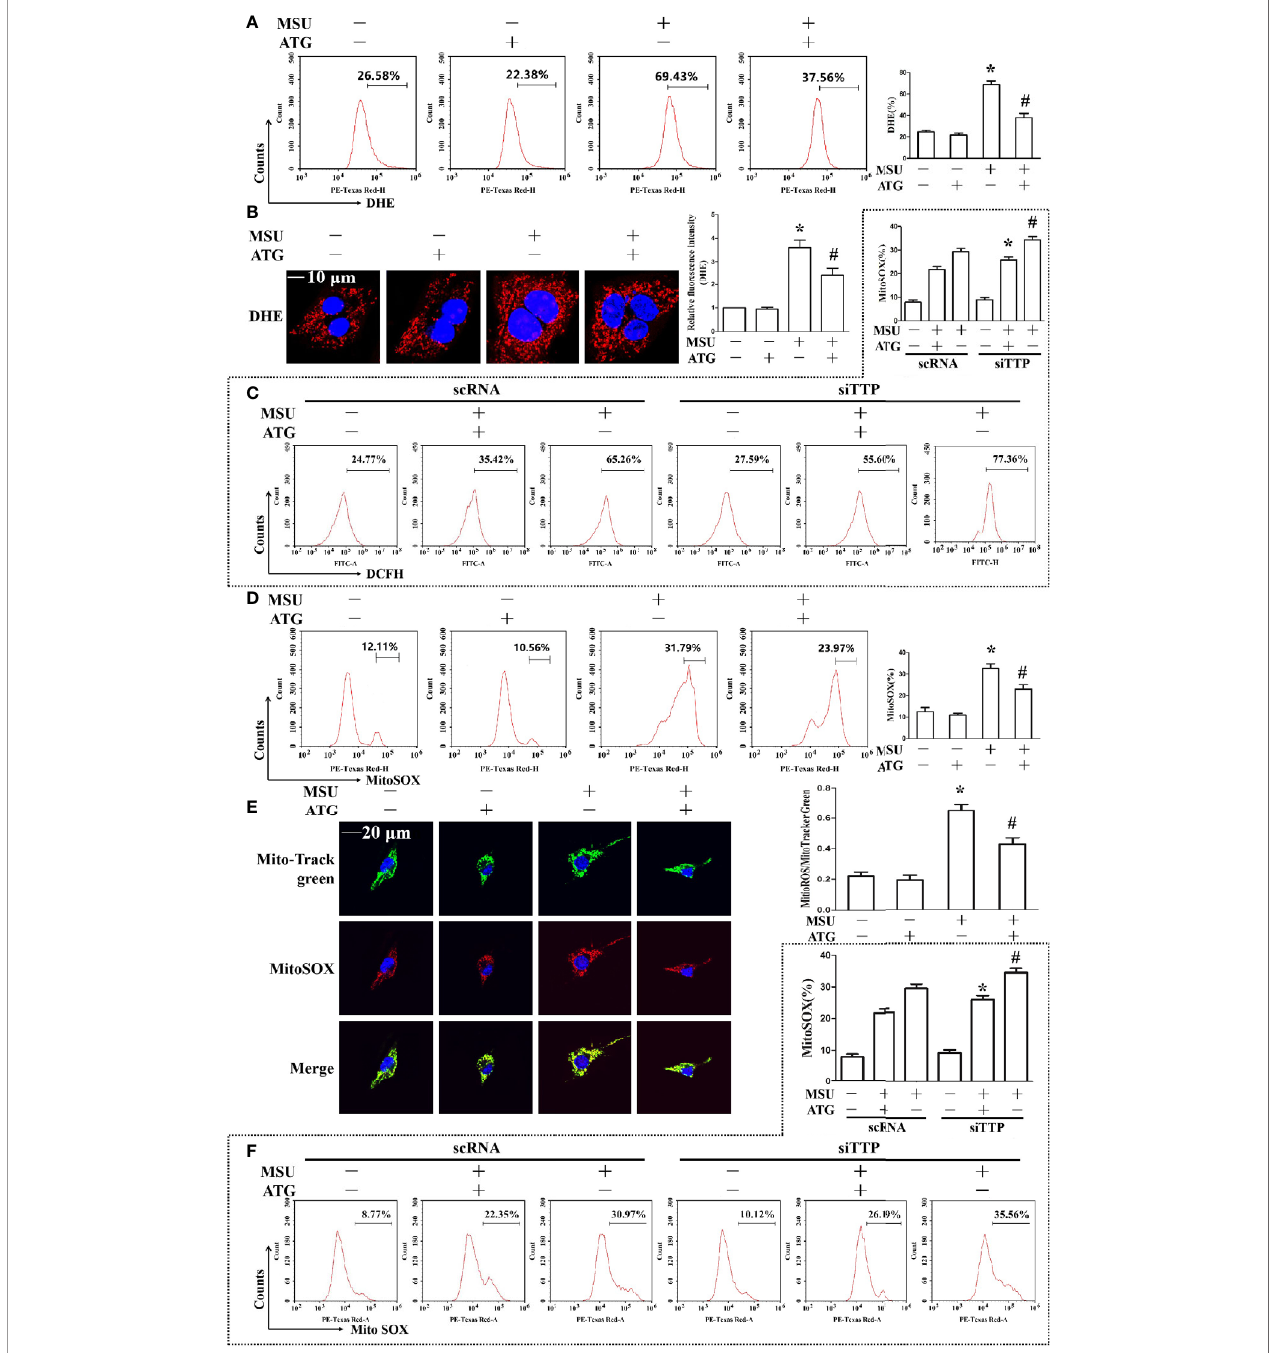
FIGURE 5 | Effects of ATG administration on the MSU crystal-induced production of intracellular total ROS, mitochondrial ROS and mitochondrial membrane potential. (A, B, D, E) J774A.1 cells were pretreated with ATG (5 m M) for 1 h, primed with LPS for 1 h and then treated with MSU crystals (50 m g/ml) for 9 h. *P < 0.05 vs. without MSU crystals treatment; # P < 0.05 vs. MSU crystals treatment +vehicle. (C, F) J774A.1 cells were either transfected with scRNA or siTTP for 48 h, treated with 5 m M ATG for 1 h, primed with LPS for 1 h, and then stimulated with MSU crystals (50 m g/ml) for 9 h. *P < 0.05 vs. MSU crystals treatment + ATG + scRNA; # P < 0.05 vs. MSU crystals treatment + scRNA. (A, B) Cells were stained with DHE fl uorescent probe, then the fl uorescence intensity of DHE was measured by FACS or images were captured by Laser confocal microscope. Scale bar: 10 m m. (C) The fl uorescence intensity of DCFH was measured by FACS. (D) Cells were stained with MitoSOX and then FACS was used to detect the fl uorescence intensity of MitoSOX. (E) Cells were stained with MitoSOX and Hoechst 33342. Laser confocal microscope is used for image capture and fl uorescence intensity analysis. Blue shows nuclei stained with Hoechst 33342. Scale bar: 20 m m. (F) FACS was used to detect the fl uorescence intensity of MitoSOX. All the data are expressed as the means ± SEM from n=3 independent